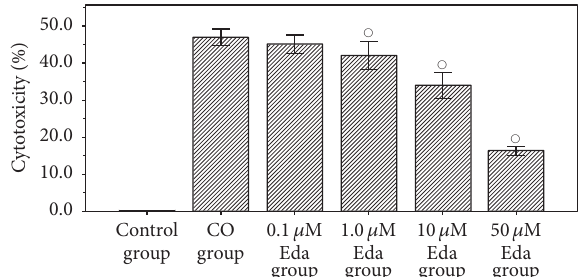
Figure 1: The results of cytotoxicity test. Cytotoxicity of each group was assessed using the MTT assay. Compared with CO group: ∘ 𝑃 <